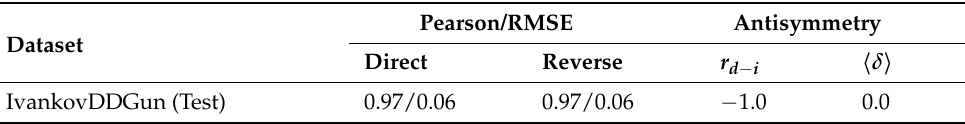
Table 3. Results on the IvankovDDGun test set: The performance of ACDC-NN-Seq in learning DDGun3D was measured in terms of Pearson correlation coefficient (r) and root mean square error (RMSE). The antisymmetry property was assessed in terms of Pearson correlation coefficient ( r d − i ) and the bias ( (cid:104) δ (cid:105) ) between the predicted values. RMSE and (cid:104) δ (cid:105) are expressed in kcal/mol. IvankovDDGun (Test) is the test set extracted from the IvankovDDGun artificial dataset. Pearson/RMSE Antisymmetry Dataset Direct Reverse r d − i 〈 δ 〉 IvankovDDGun (Test) 0.97/0.06 0.97/0.06 − 1.0